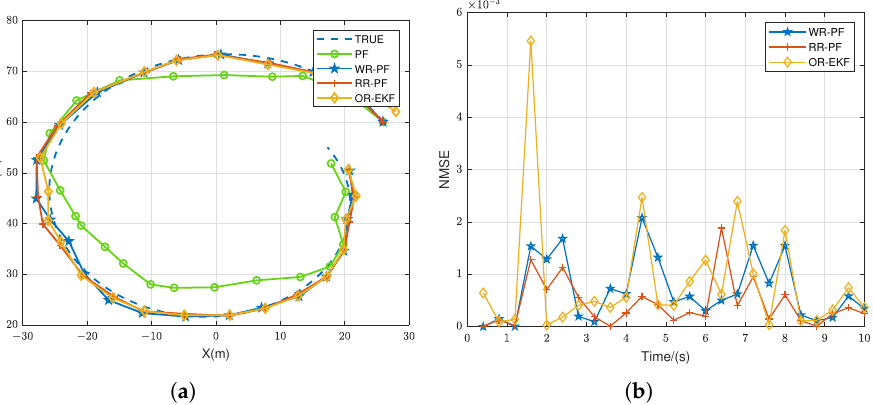
Figure 3. Performance comparisons on simulated data. ( a ) Estimated target locations. ( b ) Estimated